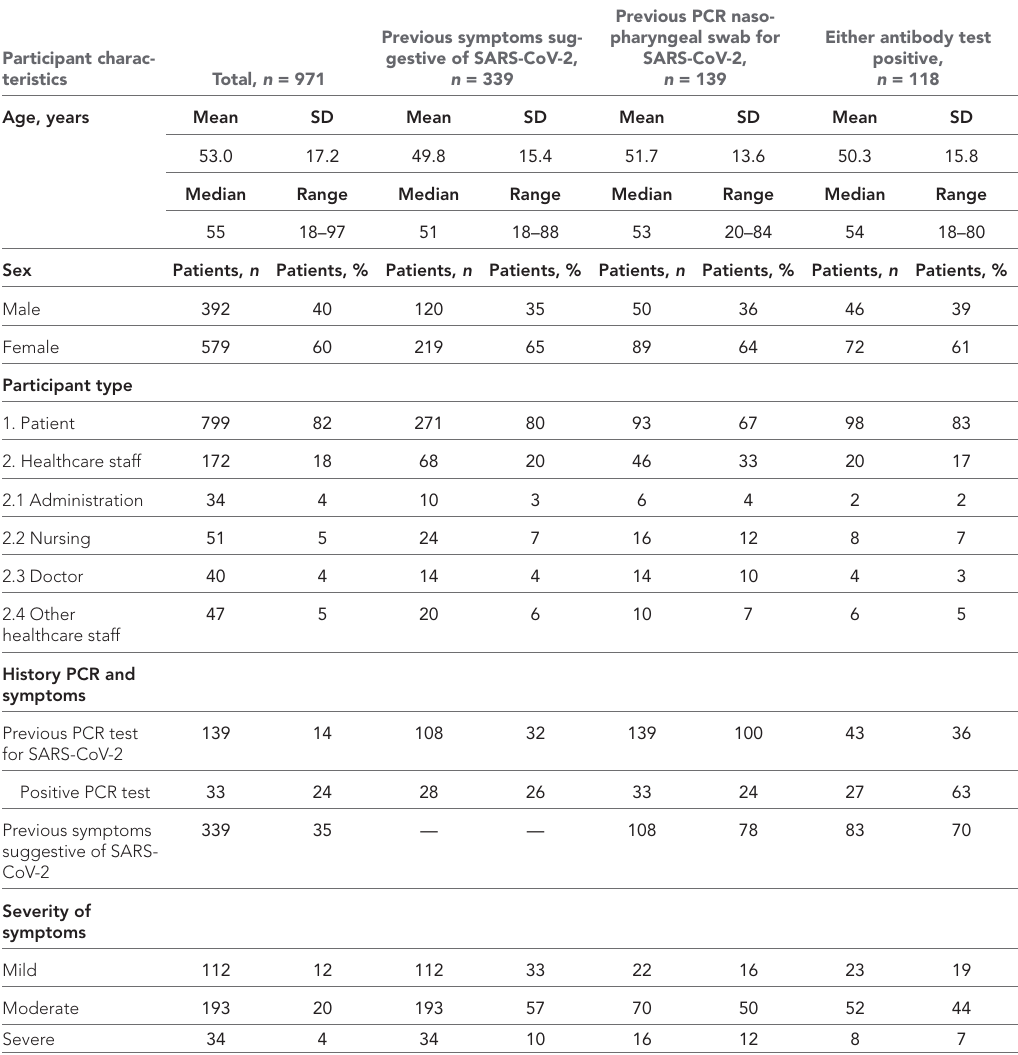
Table 2 Baseline characteristics of all participants, including previous symptoms, PCR testing, and antibody